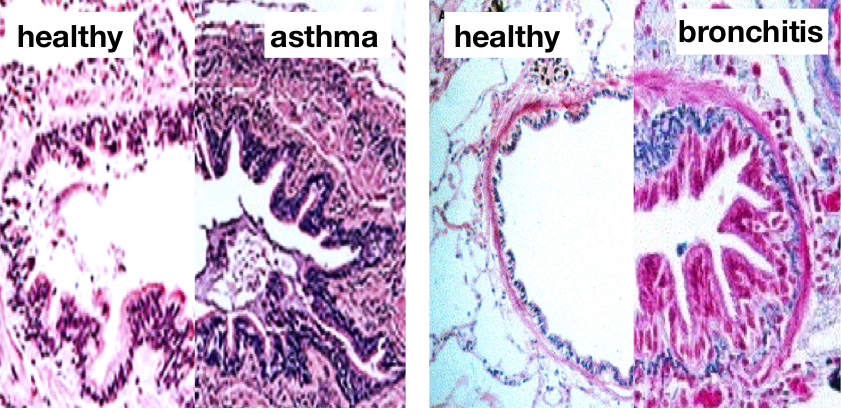
Figure 1. Airway wall remodeling in chronic lung disease. In contrast to the healthy airway wall, the airway wall in asthma, left, and chronic bronchitis, right, displays airway constriction , associated with smooth muscle thickening at the outer airway wall, and airway inflammation , associated with mucosal growth at the inner airway wall. These changes manifest themselves in an increase in pressure at the outer wall and an increase in volume at the inner wall, resulting in a narrowing of the lumen and progressive airflow obstruction; adapted from